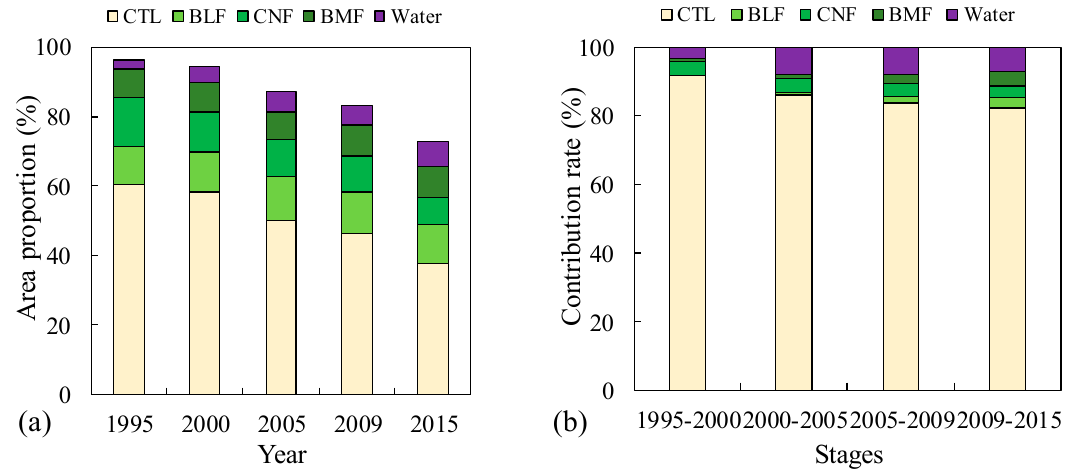
Figure 6. Area proportion ( a ) and contribution rate to urban expansion ( b ) from 1995 to 2015.